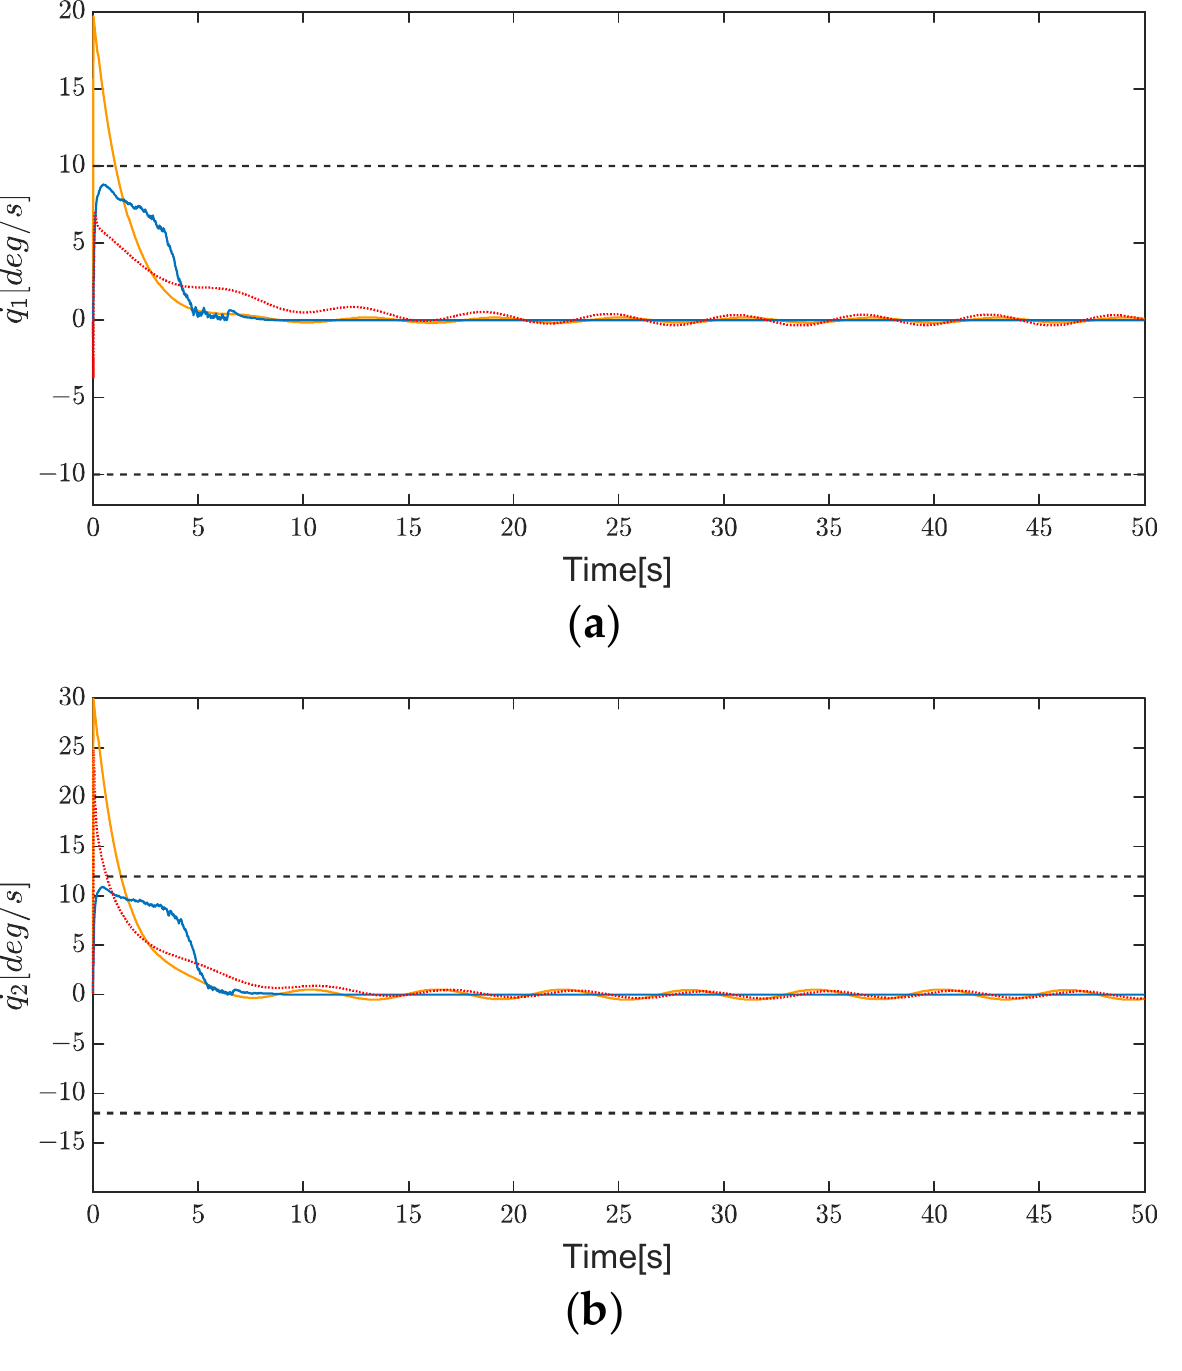
Figure 14. Comparison of angular velocity to [26,33] in case 2: the [26] scheme (yellow solid line), the [33] scheme (red dash line), the proposed scheme (blue solid line), the angular velocity constrains (black dashed line); ( a ) Joint 1. ( b ) Joint 2.